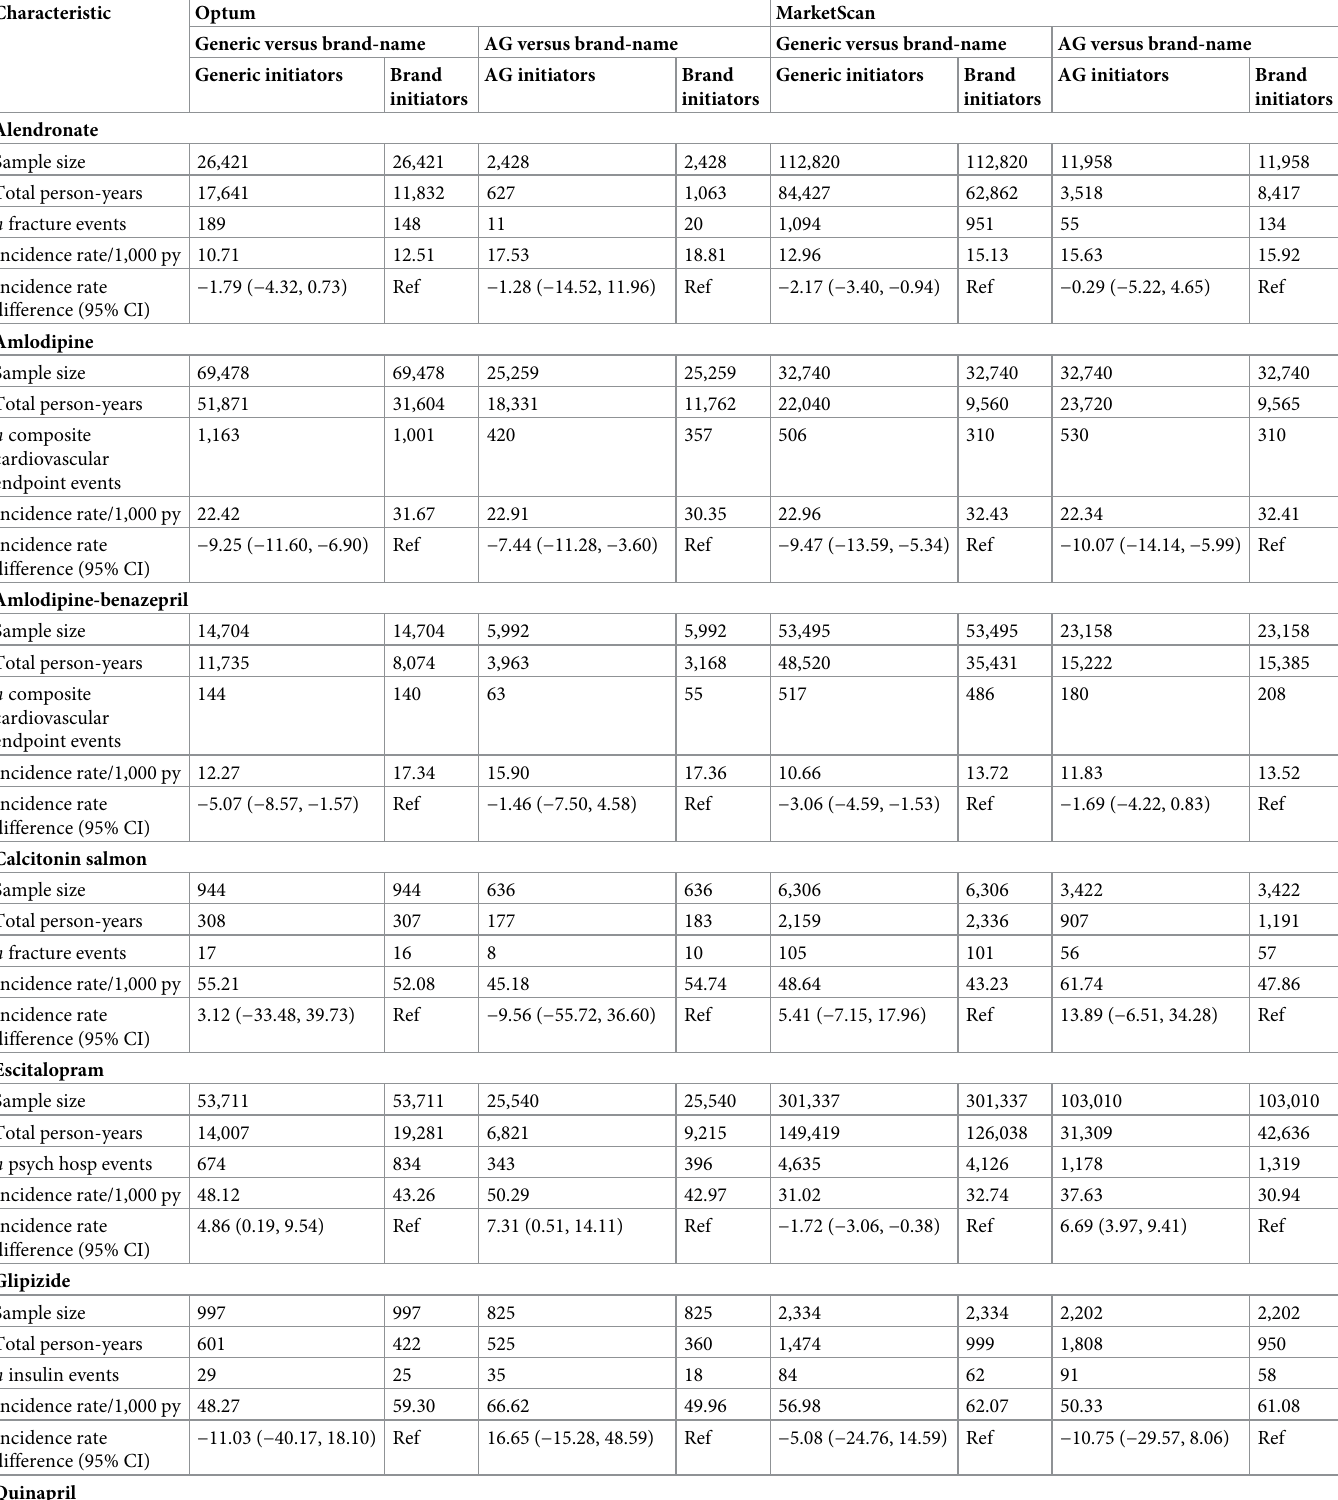
Table 4. Outcome incidence rates for generic or authorized generic (AG) versus brand initiators after 1:1 propensity score matching in each database.